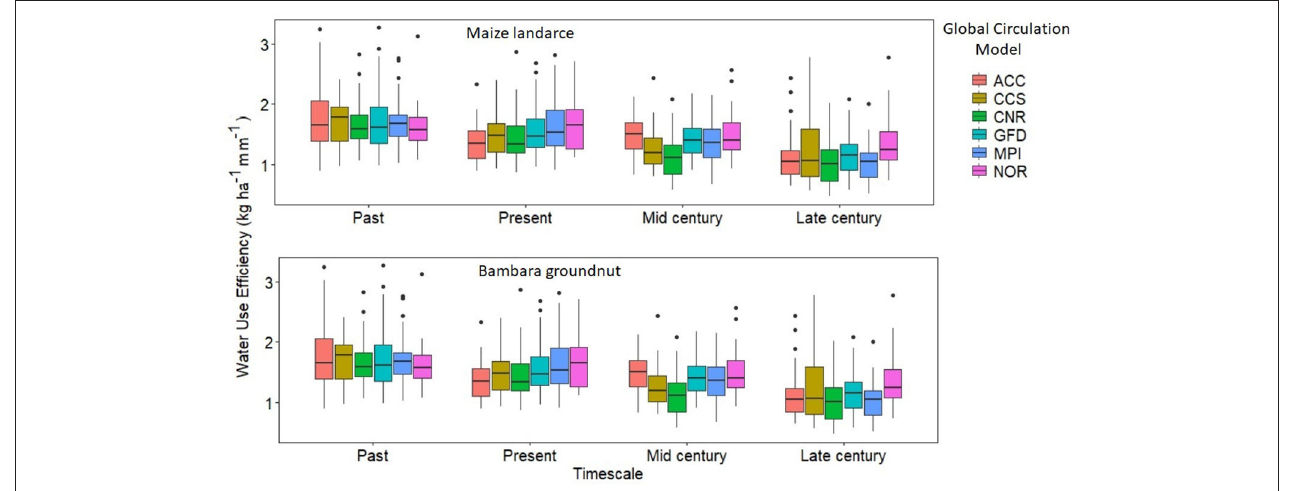
FIGURE 6 | Calculated water use efficiency (kg ha − 1 mm − 1 ) for maize landrace and bambara groundnut across the six GCMs (ACC, CSS, CNR, GFD, NOR, and MPI) for each timescale (Past, Present, Mid-, and Late-century). Bambara groundnut F -statistic: 2.122 on 3 DF, P -value: 0.1 and bambara groundnut F -statistic: 4.543 on 3, P = 0.003.